Question: Provide a one-line summary of what is displayed.
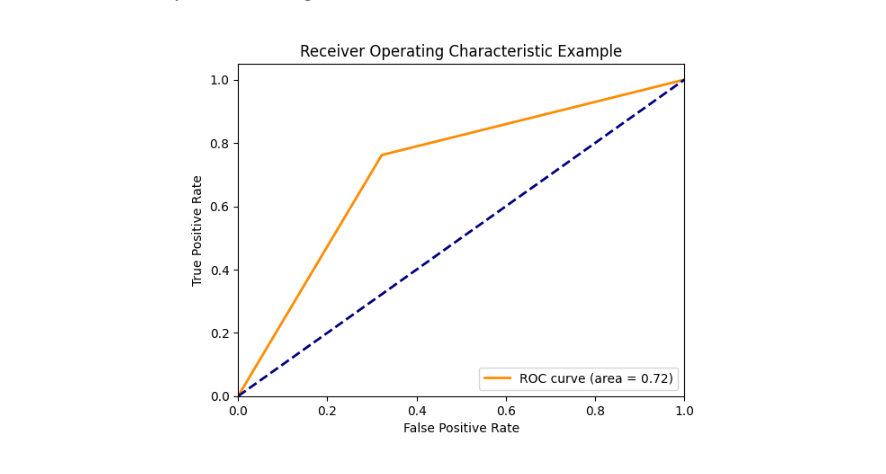
Answer: The ROC curve visually represents the Receiver Operating Characteristic for the Generative Adversarial Network (GAN), offering insights into its discriminative performance and the trade-off between true positive and false positive rates